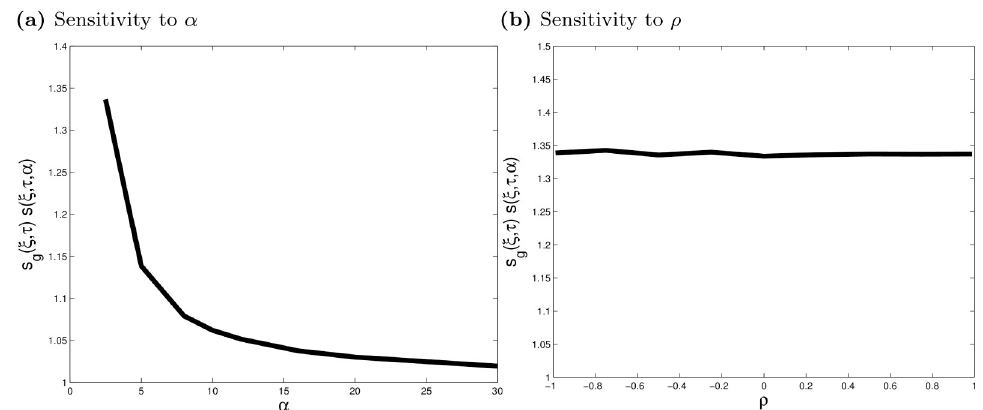
Fig 3. Sensitivity of s ( ξ , τ ) s ( ξ , τ , α ) to α and ρ . Panel (a) shows the sensitivity of the nonlinear component to α . The tail g index varies from 2.5 to 30. Panel (b) shows the sensitivity to ρ (for α = 2.5). Both plots are for τ = 0.75 and ξ = 0.95.